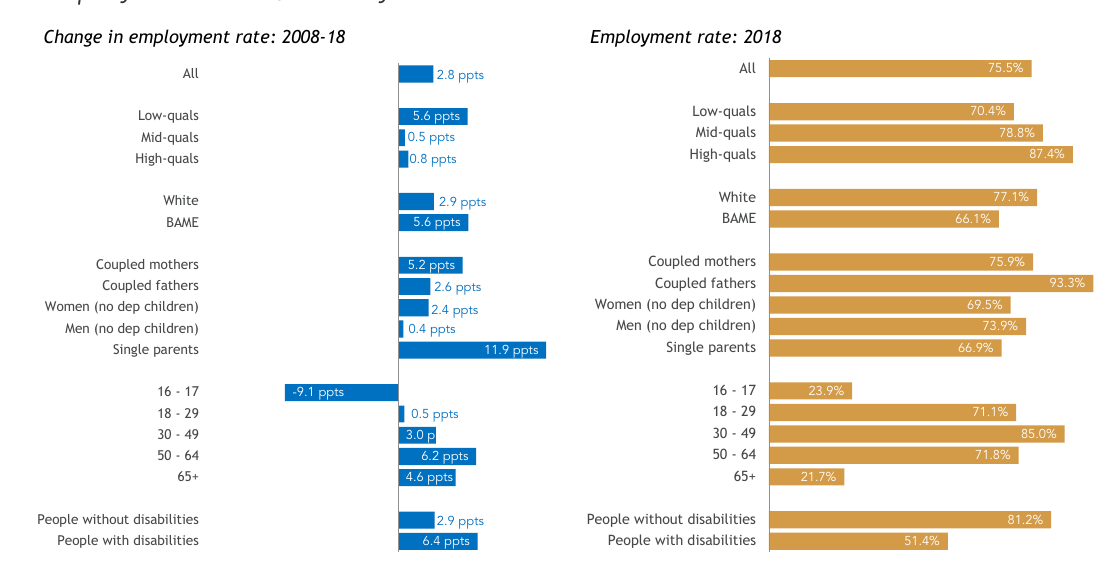
Figure 5: Employment rates have risen dramatically for groups furthest from the labour market Employment rates, 16-64 year